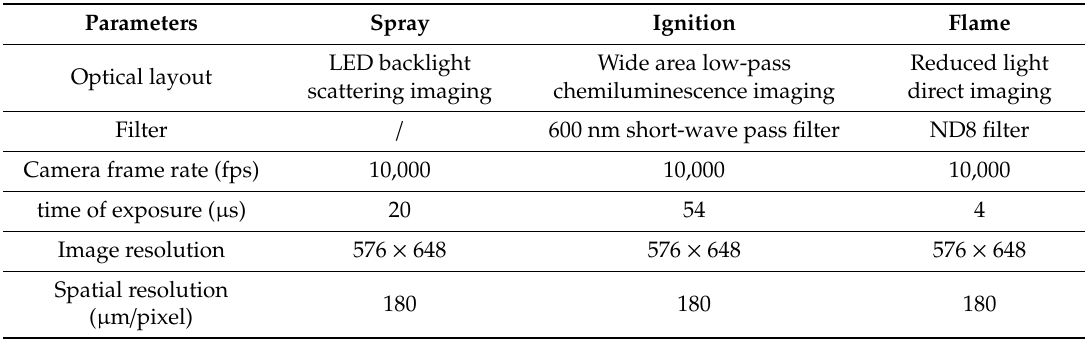
Table 1. Imaging conditions.